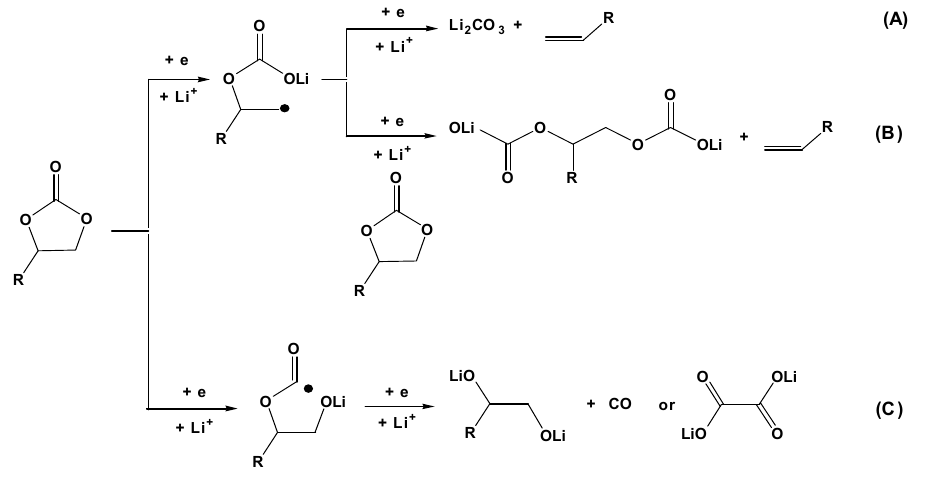
Figure 5. Schematic illustration of the effect of Li+-solvation on the activation barrier of surface reduction for organic